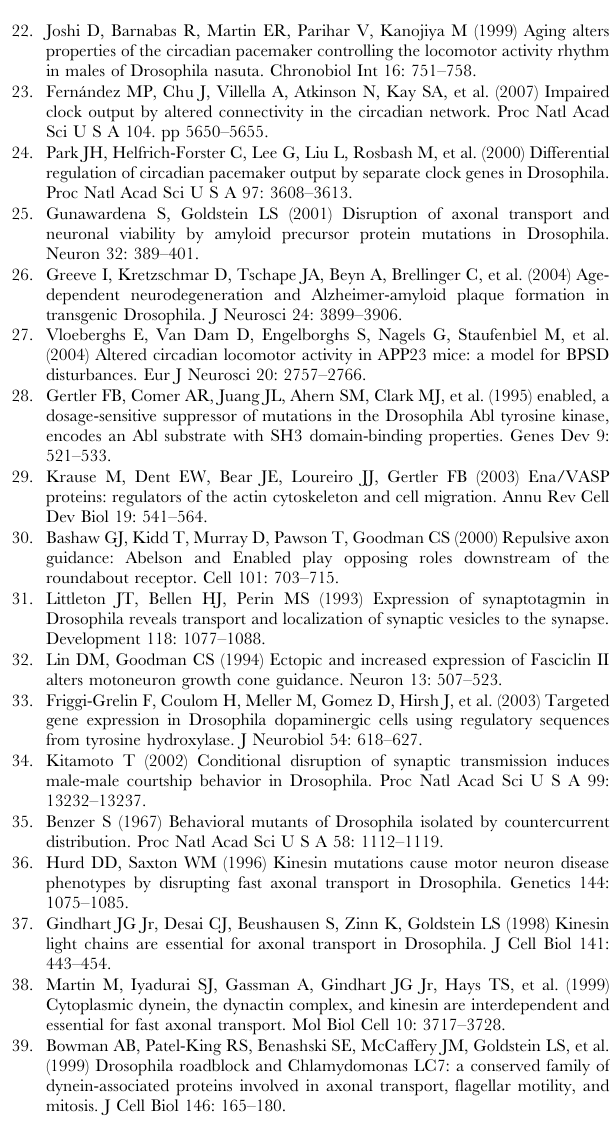
Table S2 Synchronized flies were examined in the automated behavioral paradigm, as explained in the legend to Table S1. The table includes all the experiments described in Figures 3 and